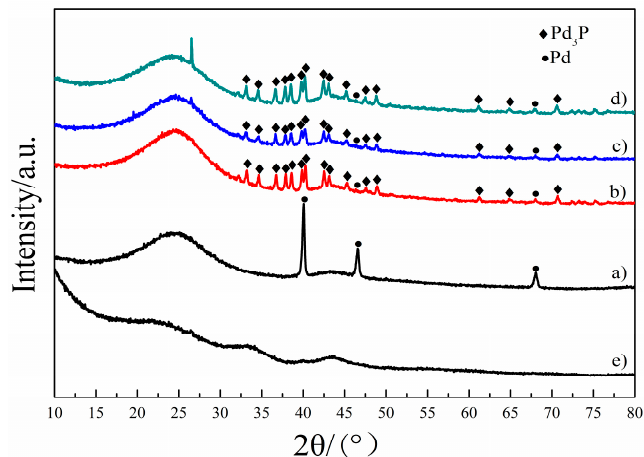
Figure 2. XRD patterns of Pd-P/C catalysts treated with different phosphating temperature. ( a ) Pd-P(32)/C(330); ( b ) Pd-P(32)/C(400); ( c ) Pd-P(32)/C(500); ( d ) Pd-P(32)/C(600); ( e ) PdO/C without phosphating and calcination treatment.